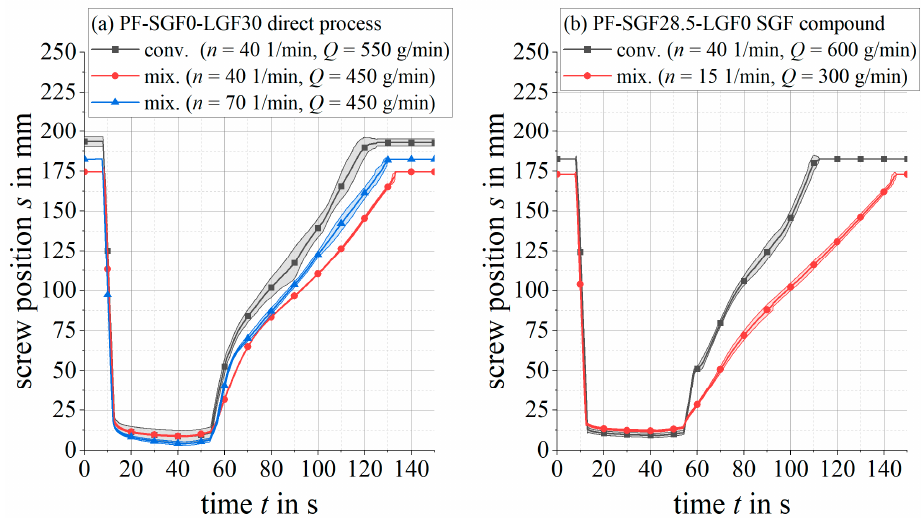
Figure 6. Injection pressure for LGF and SGF formulations with conveying and mixing screw.